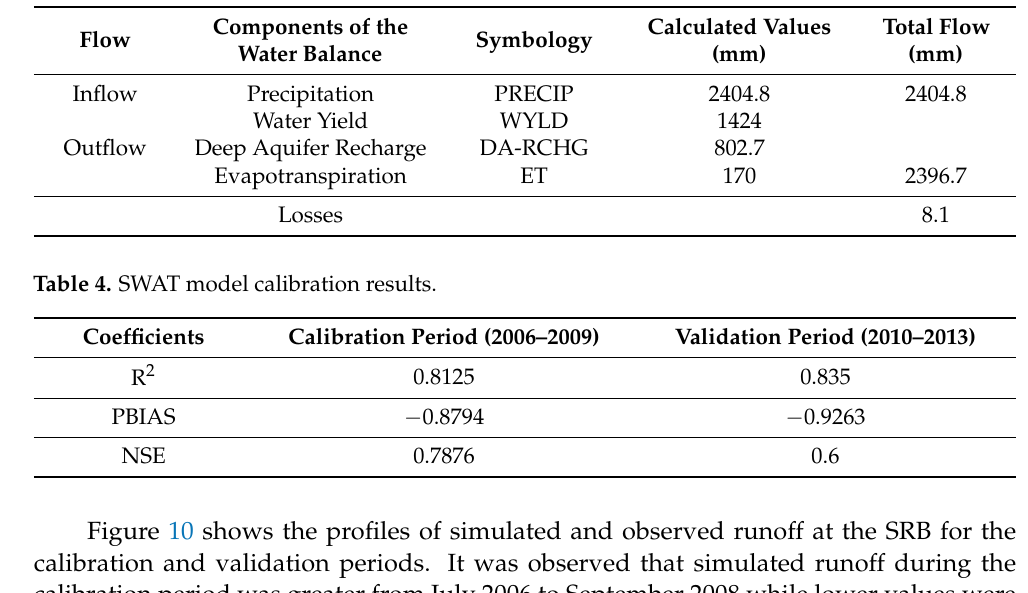
Table 3. Annual average water balance for the SRB (1991–2017).